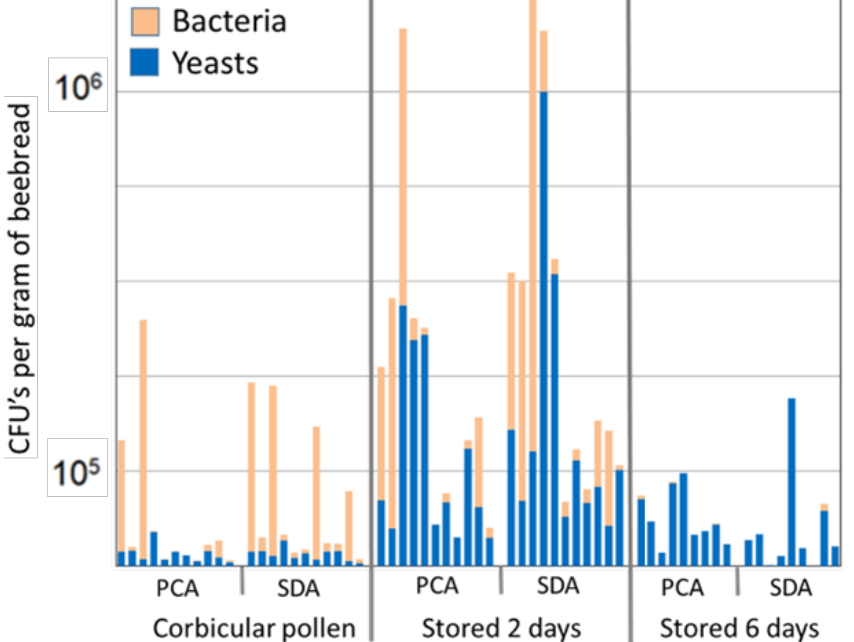
Figure 4. The relative ratio of yeasts and bacteria accounting for 99% of identified CFUs. Identical samples were plated on standard plate count agar (PCA) and Sabouraud dextrose agar (SDA) and grown aerobically. Isolates were identified by high-resolution light microscopy from 11 colonies during spring colony growth.